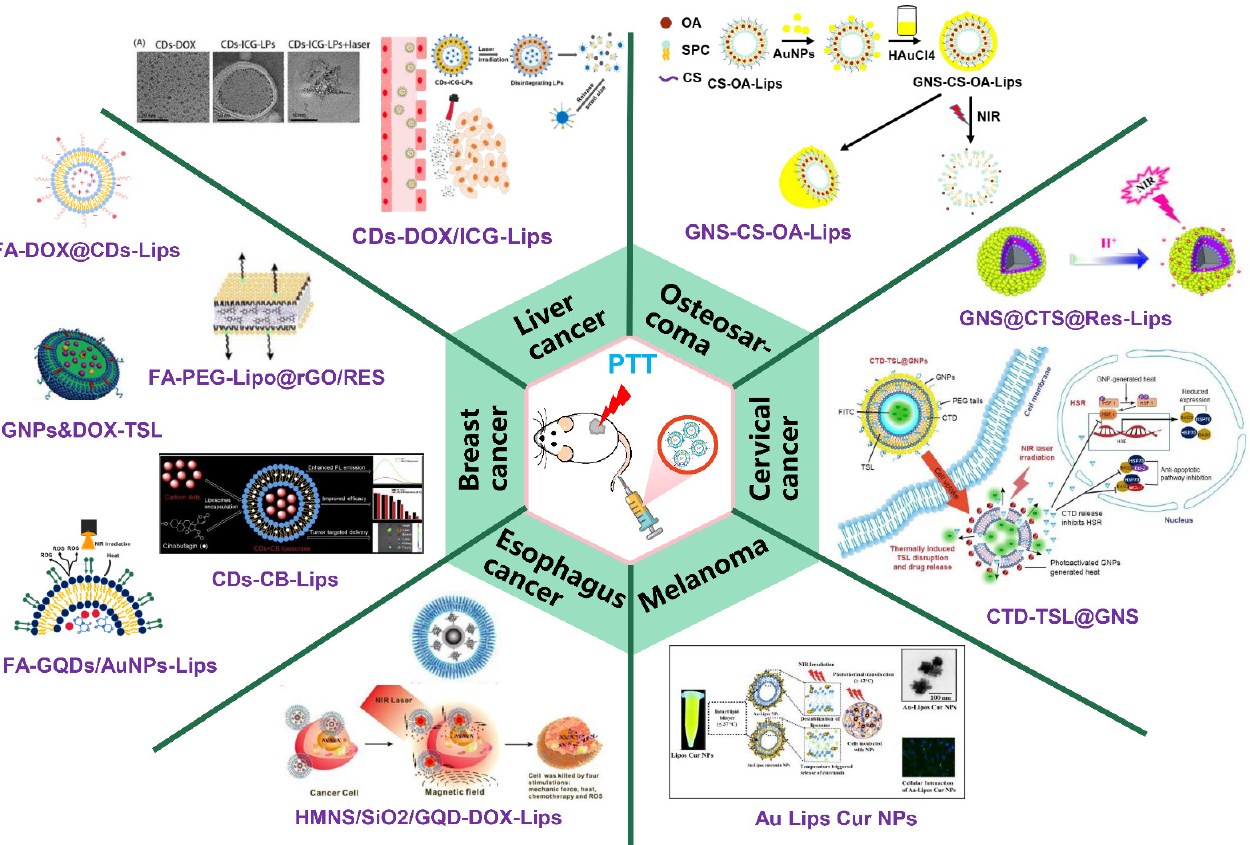
Figure 6. The recently fabricated NIRN-Lips for PTT of different types of cancer. Reprinted with permission from [9], John